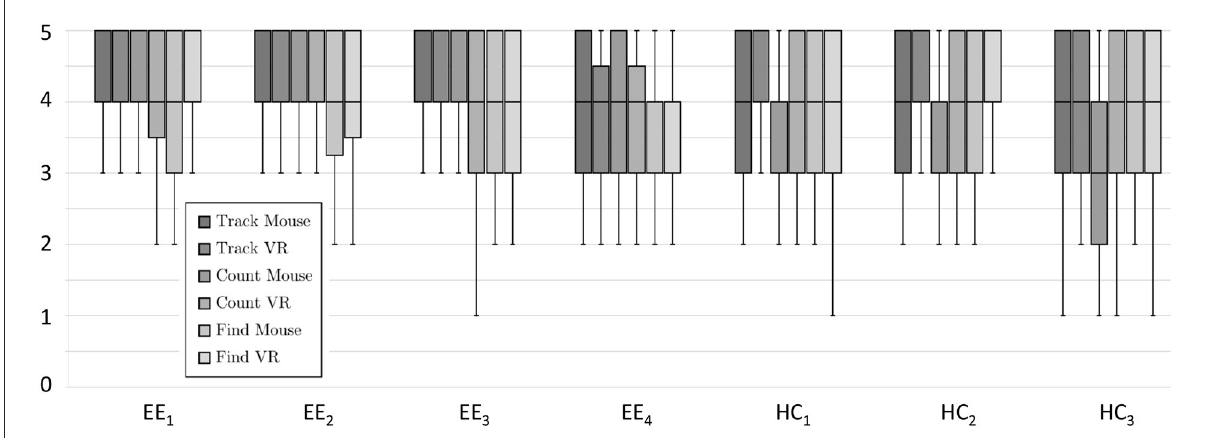
FIGURE4 Box-plots of the effort expectancy and the hedonic motivation results (5-points Likert scales). Additionally, the “x” shows the mean value.